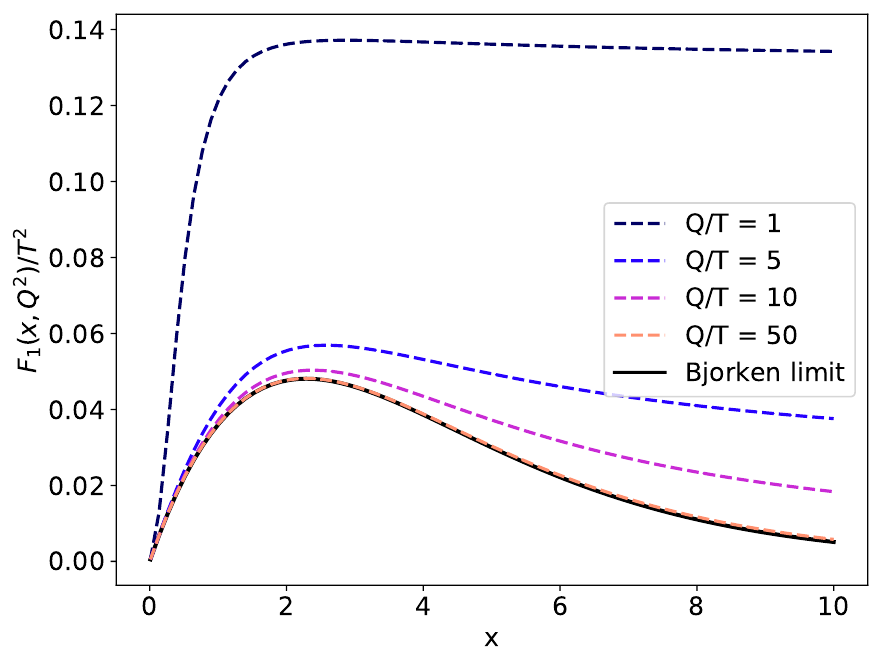
Figure 2 . The structure function F 1 ( x, Q 2 ) of the free plasma for different values of Q 2 , together with the Bjorken limit eq. (2.16). Here we have set N c = 3 and P